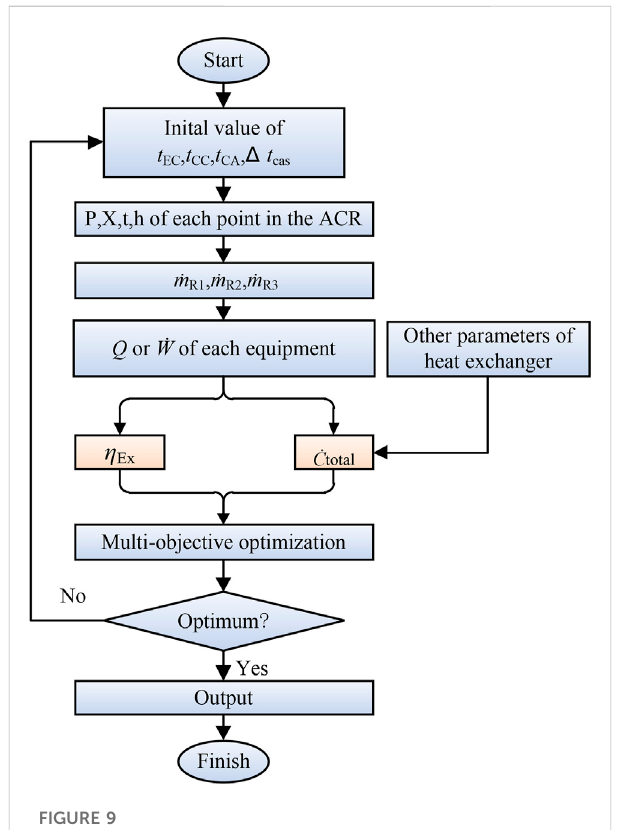
FIGURE 9 Schematic diagram of the multi-objective optimization.